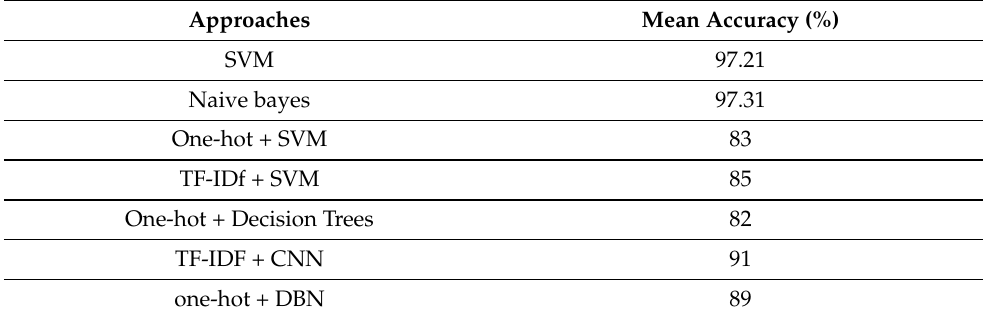
Table 4. Prediction accuracy with different